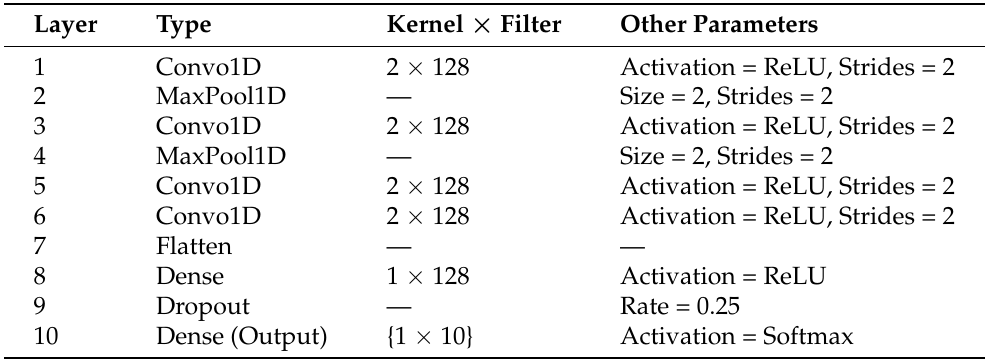
Table 3. Proposed model detailed